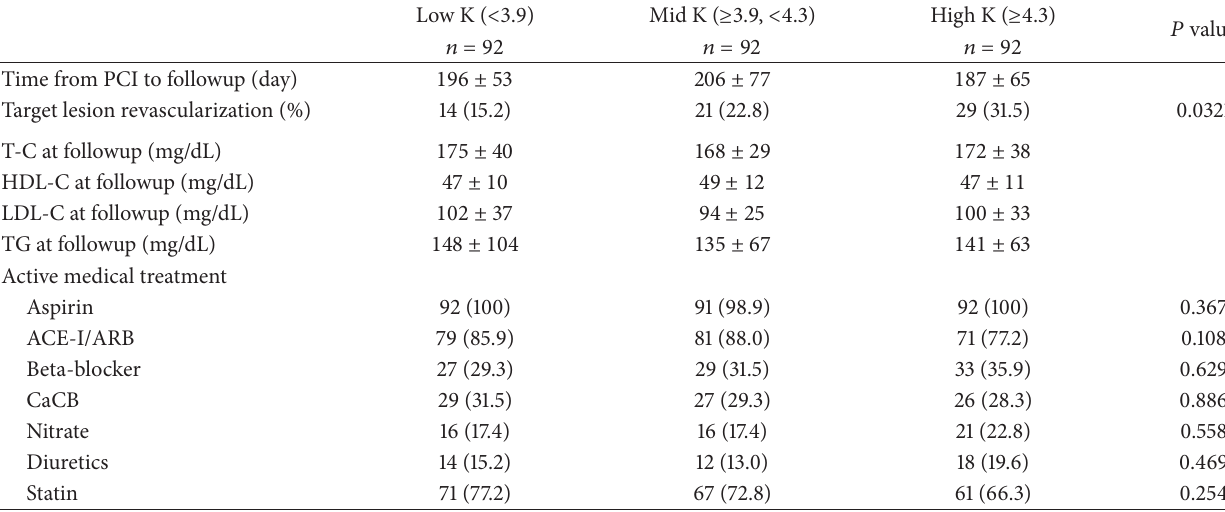
Table 3: Clinical characteristics of the patients at